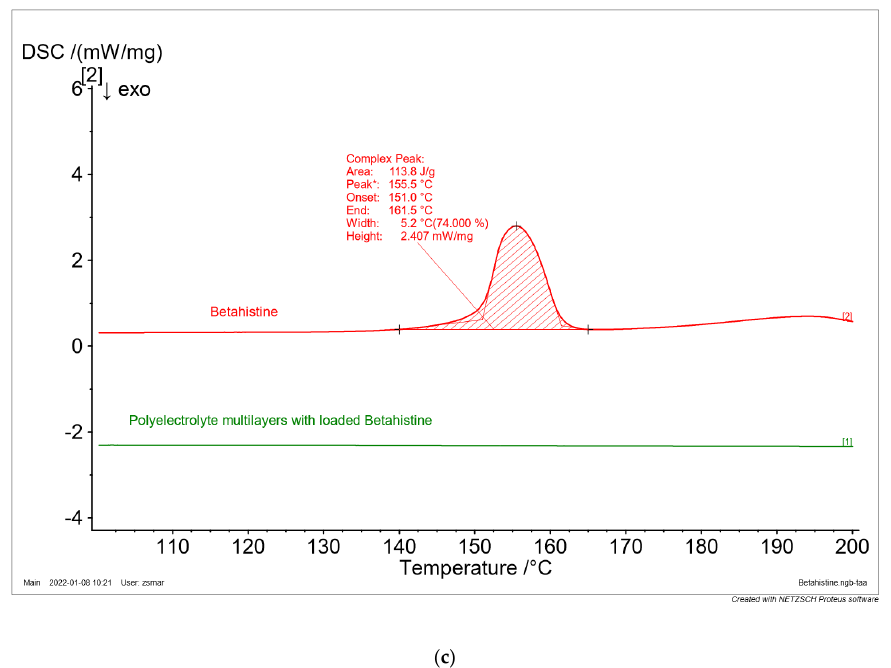
Figure 6. DSC thermogram of multilayer casein/chitosan films loaded with benzydamine hydrochloride ( a ), tolfenamic acid ( b ) and betahistine dihydrochloride ( c ) compared to pure drugs.